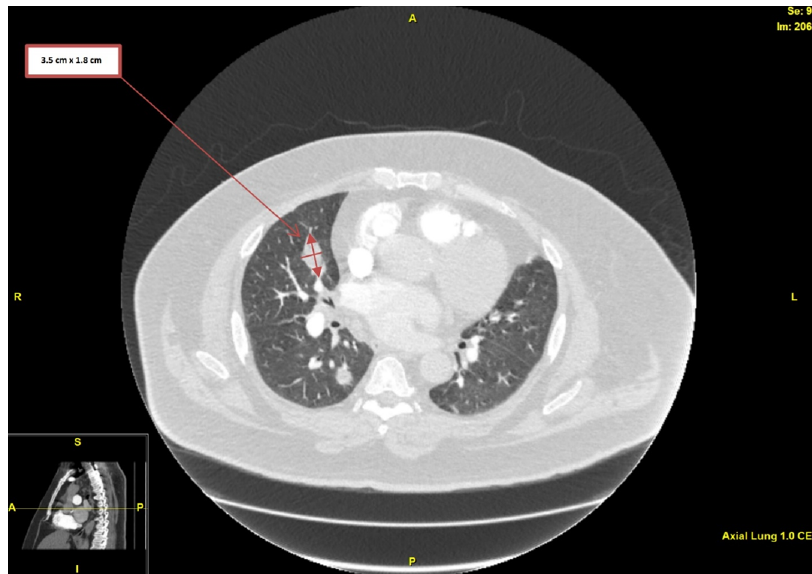
Figure 1. Computed tomography angiography of the chest, showing nodularity with associated cavitation (largest measuring 3.5 × 1.8 cm in diameter). The patient then underwent transthoracic echocardiogram (TTE), which revealed large ICD lead vegetations in the RV (Figure 2A). Moderate aortic valve regurgitation was noted, but without any apparent valve vegetations. Due to mild symptoms, the ab- sence of fever, and hemodynamic stability, it was decided to defer antibiotic initiation until further workup was done. After 12 h, all four blood culture samples (two aerobic, two anaerobic) were positive for ampicillin-susceptible, vancomycin-susceptible E. du- rans , with minimum inhibitory concentrations (MICs) of ≤ 2 mcg/mL and ≤ 0.5 mcg/mL,